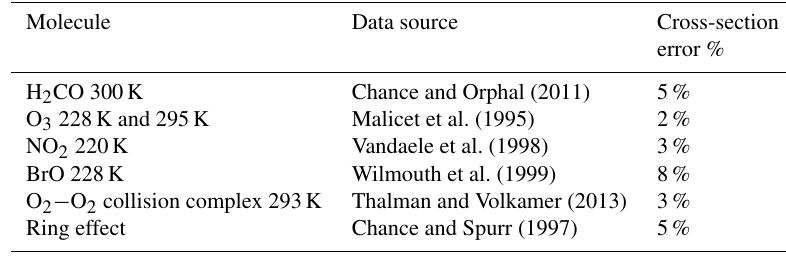
Table 2. Systematic uncertainties of the cross sections included in the fitting of H 2 CO.